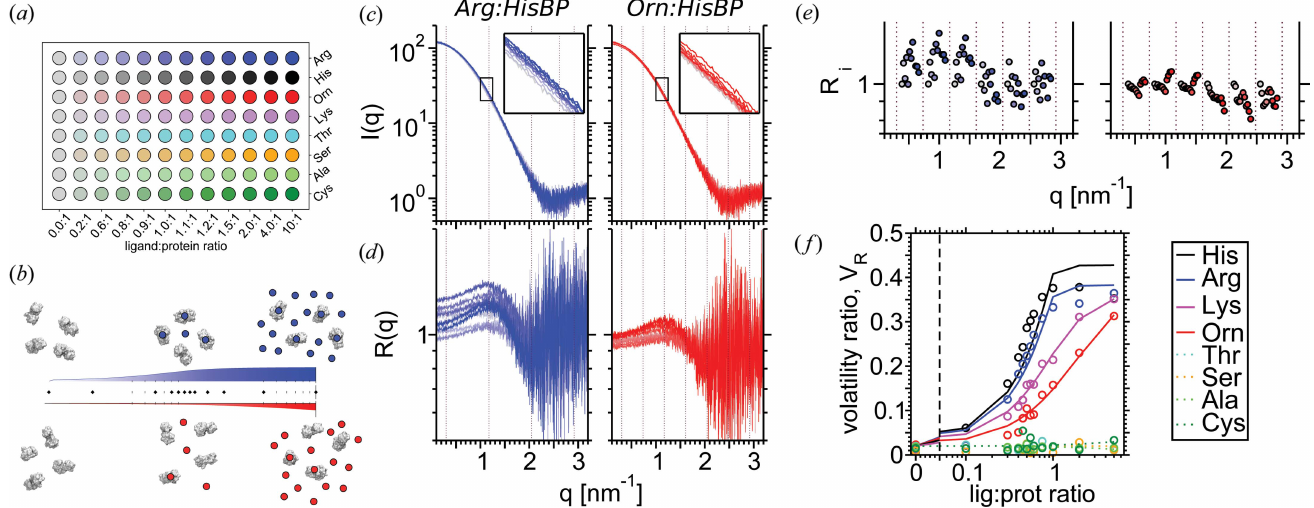
Figure 1 SAXS-based screening using the volatility ratio V R , exemplified by the histidine-binding protein (HisBP) titrations. ( a ) 96-well plate setup for small-scale screening divided into eight twelve-point titrations, spanning from the apo ligand-less measurement to the saturated ligand-excess measurement. ( b ) Theoretical binding curves for a strong (blue) and weak (red) receptor–ligand interaction at constant receptor concentrations. The former reaches saturation at approximately 1:1 ratio, whereas the latter does not saturate even at 10:1 excess. ( c ) Example titrations of 160 m M HisBP against Arg and Orn, visualized by the buffer-subtracted SAXS intensity I ( q ). The apo I ( q ) is coloured grey, with SAXS profiles of other titration points coloured according to ligand:receptor ratios. ( d ) Normalized ratio R ( q ) versus apo protein I ( q ), matching equation (4). ( e ) Geometric average R i for each complete Shannon channel, matching equation (6). Points have been horizontally shifted to aid visualization. ( f ) Computed V R curves for a preliminary titration of HisBP versus eight active and non-active